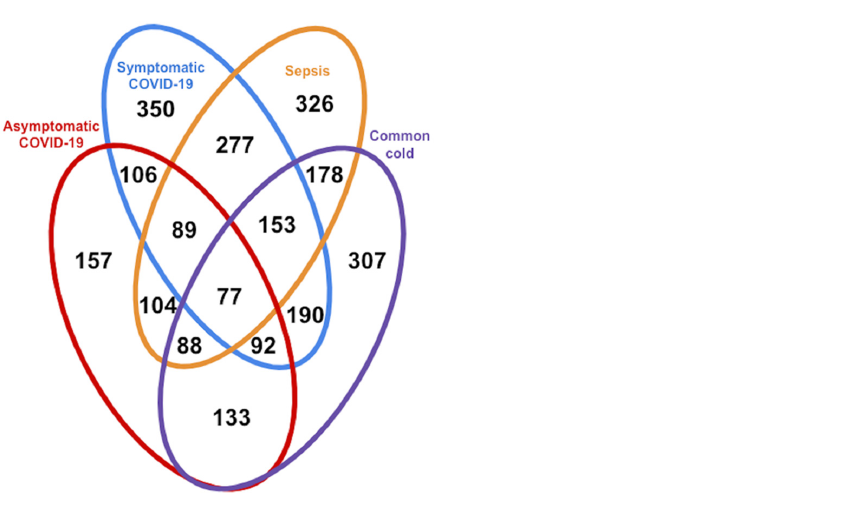
Figure 2. Venn diagram indicating number of differentially expressed biomarkers at FDR < 0.05 between healthy controls and given phenotype group(s).